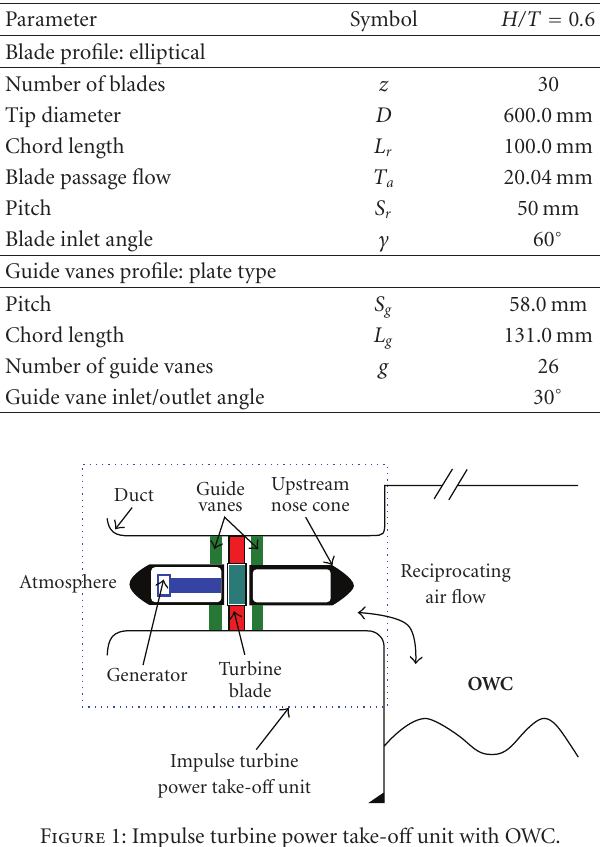
Figure 1: Impulse turbine power take-o ff unit with OWC.